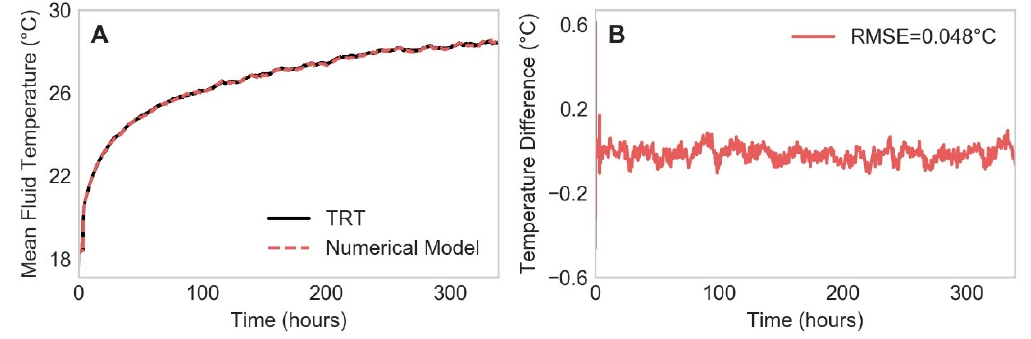
Figure 5. ( A ) Simulated TRT with best fit numerical model compared to the experimental TRT1 dataset. ( B ) Residuals of the numerically simulated TRT fit to the experimental data.